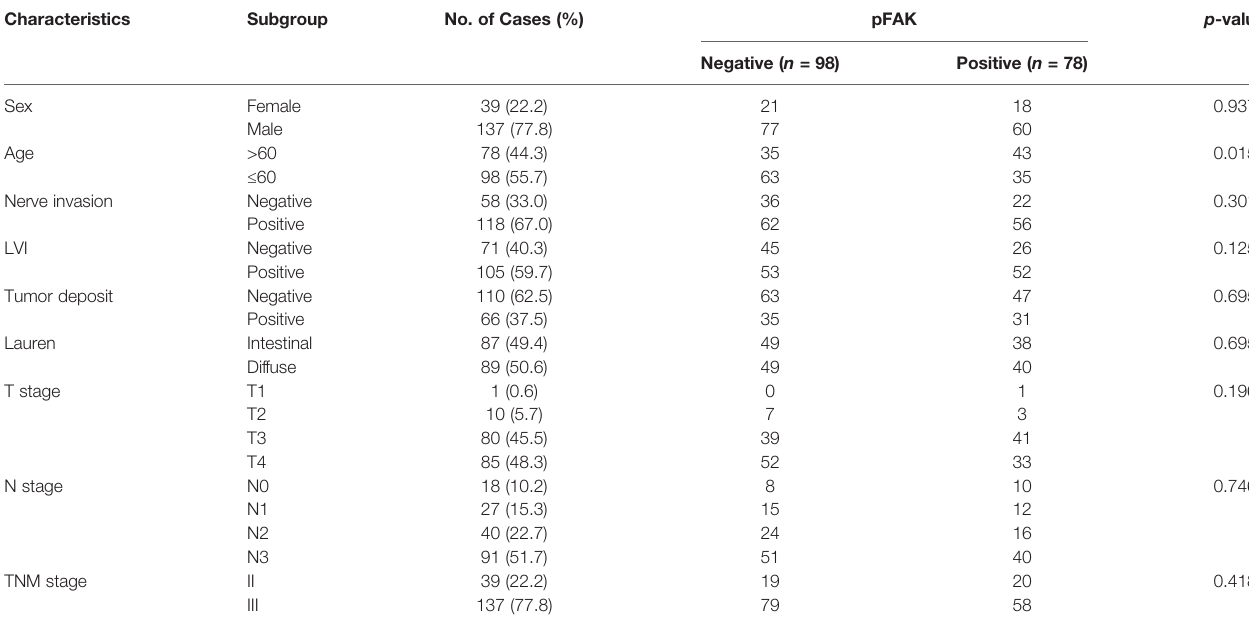
TABLE 1 | Correlation between pFAK and clinicopathologic characteristics in GCs. Characteristics